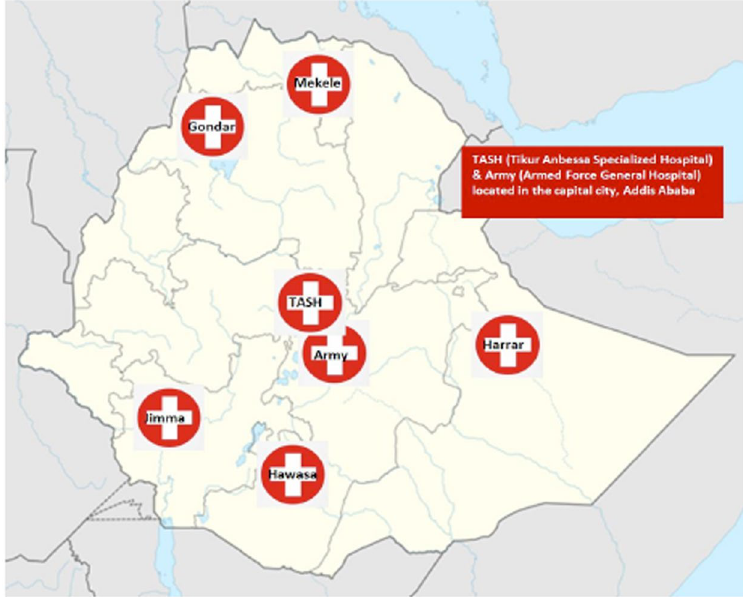
Figure 3. Geographical locations of seven university affiliated hospital study sites in